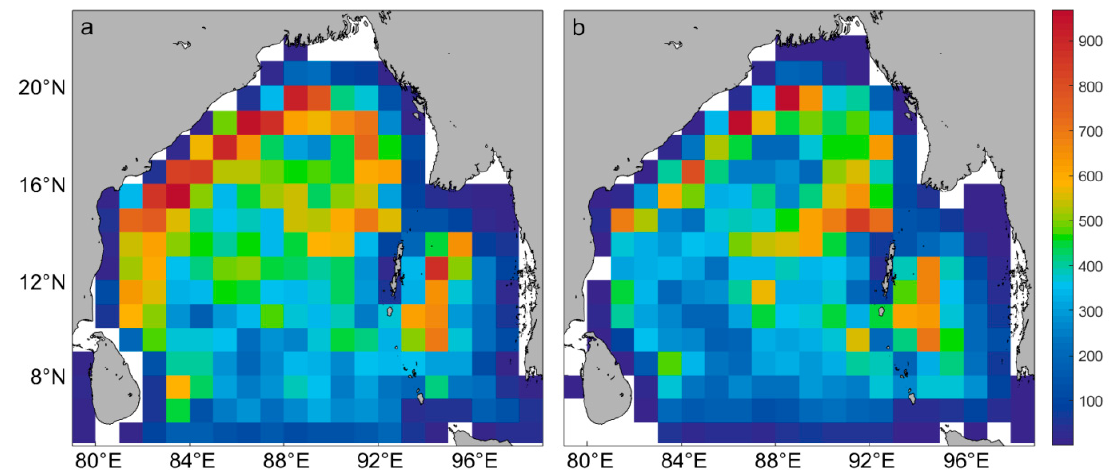
Figure 6. Spatial distribution of average eddy number (lifetime ≥ 4 weeks) over 1° × 1° bins for CEs ( a ) and AEs ( b ).